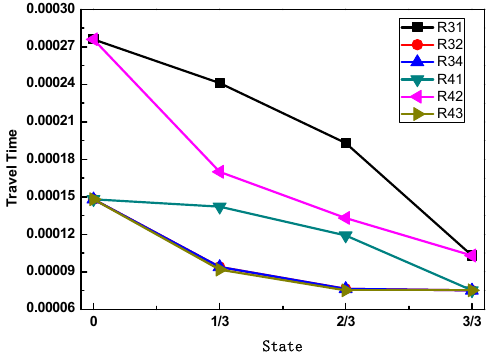
Figure 6. The arrival time of different concrete infill conditions.